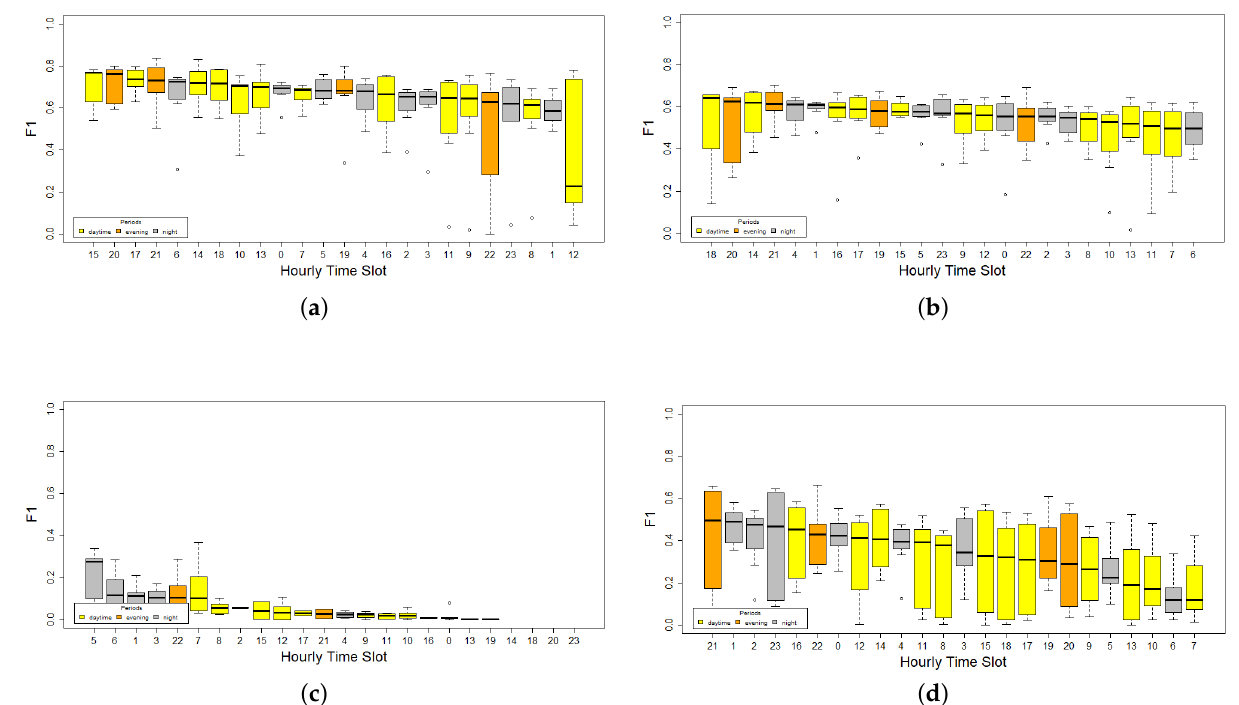
Figure 6. Statistical distributions of the F1-Score variable for every hourly time slot, broken down into the four environmental acoustic behaviors (subfigures ( a – d ) for category patterns 1, 2, 3, and 4, respectively) represented though box and whisker